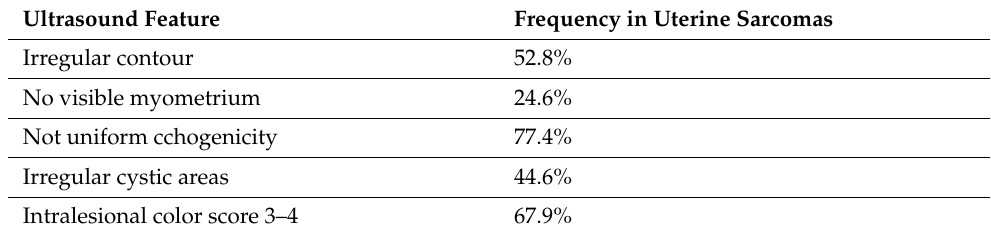
Table 1. Ultrasound features more frequently present in uterine sarcomas *.